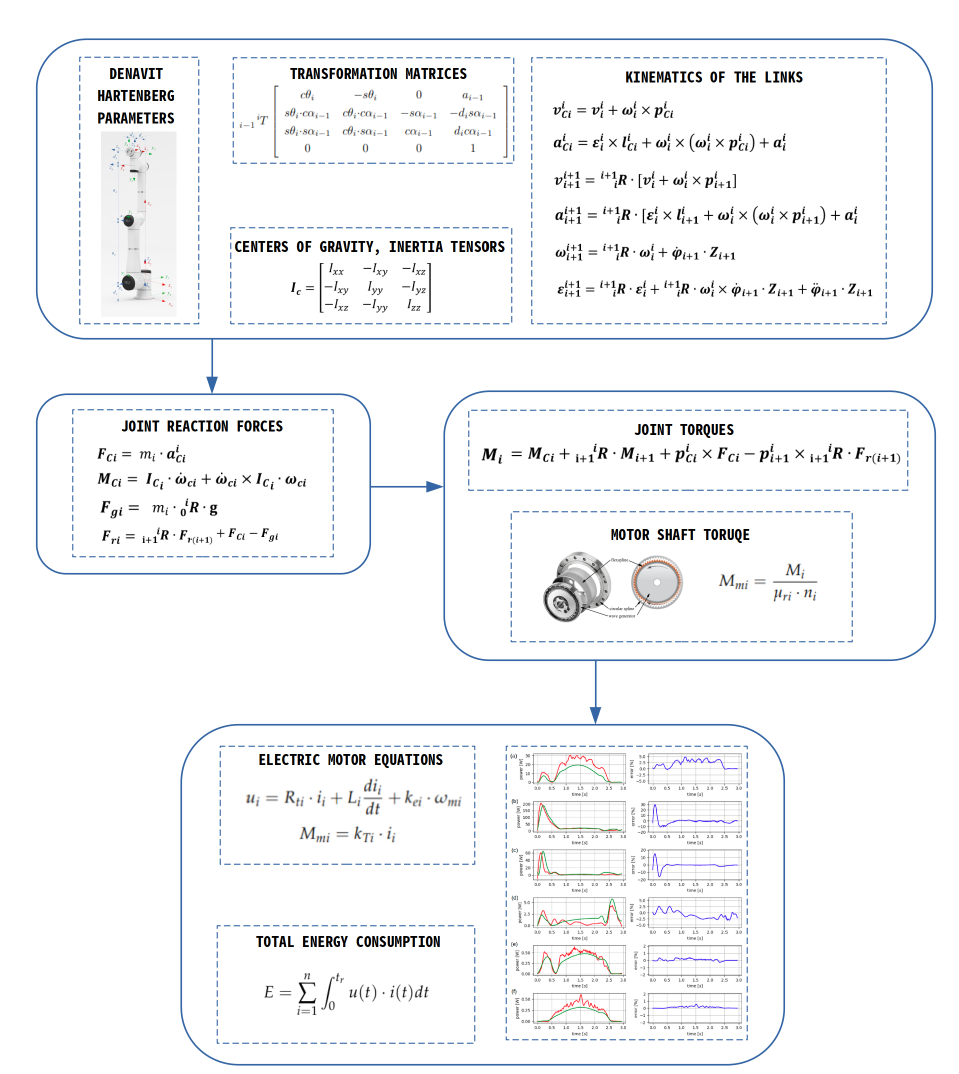
Figure 2. Graphical diagram of the process of deriving the analytical model of energy